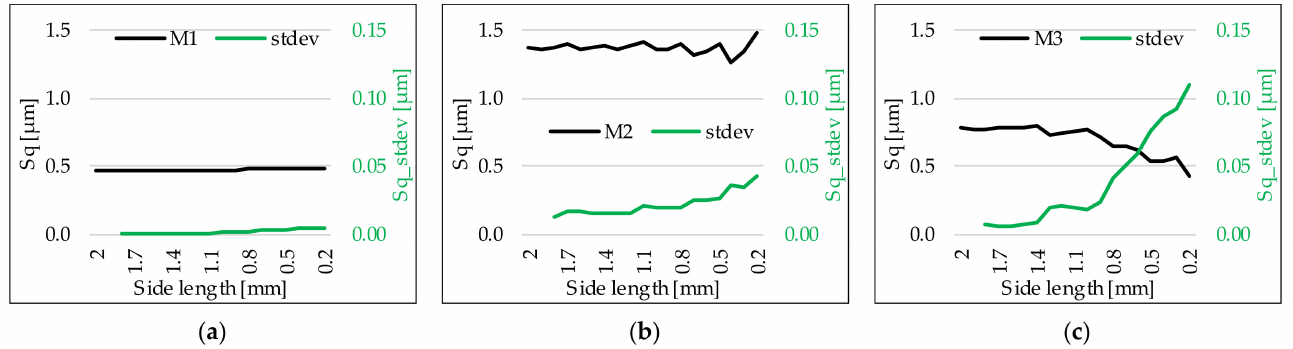
Figure 5. Sq parameters (black) and their standard deviations (green) as a function of the analyzed area (2 × 2 mm–0.2 ×